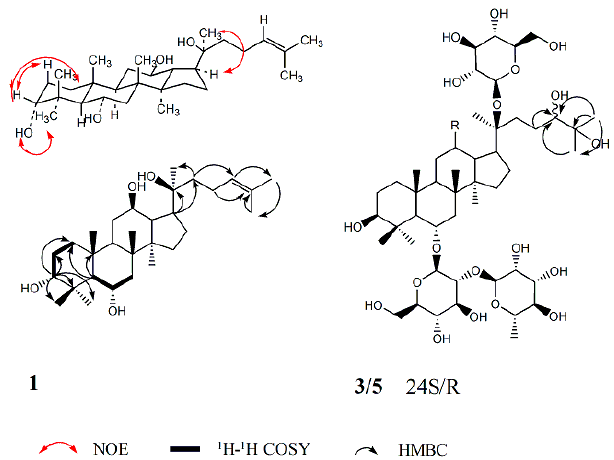
Figure 1. The important NOESY, 1 H- 1 H COSY and HMBC correlations of 1 ; the important HMBC correlations of 3 and 5 . 1 H- 1 H COSY, 1 H- 1 H correlation spectroscopy; HMBC, heteronuclear multiple bond correlation; NOESY, nuclear Overhauser effect spectroscopy.